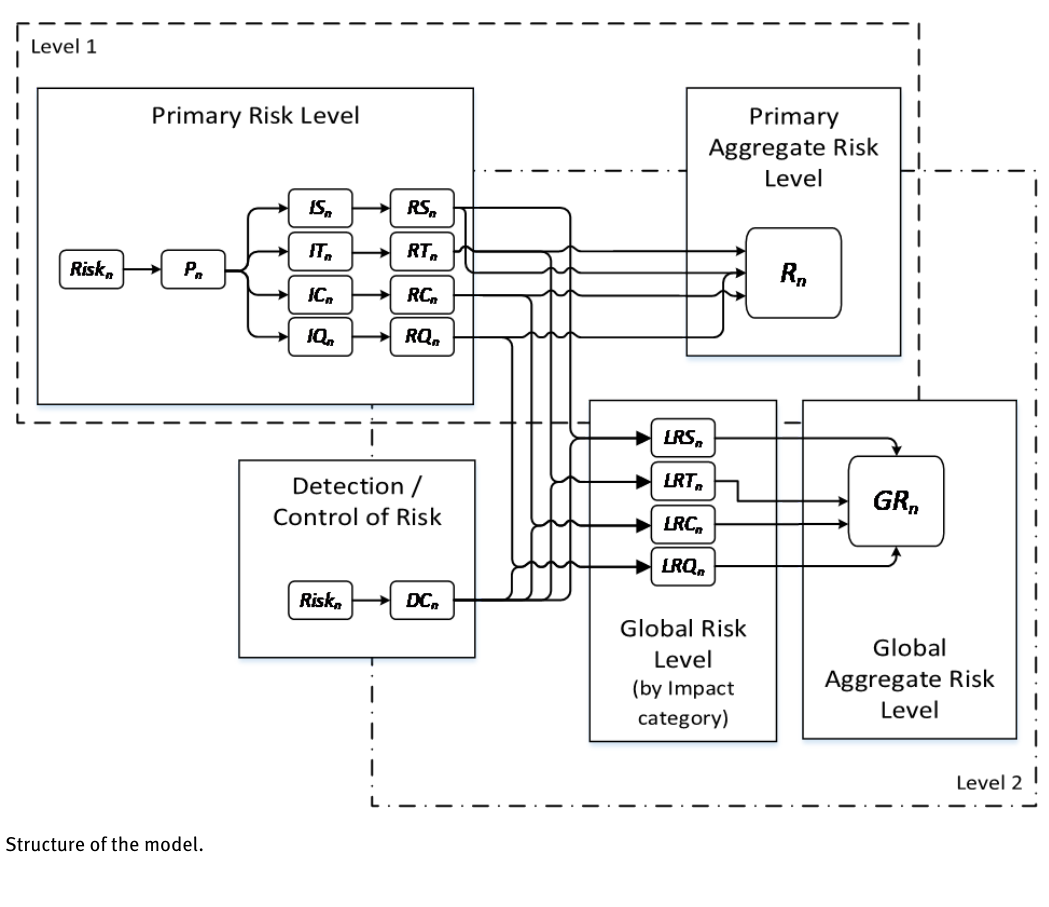
Figure 2: Structure of the